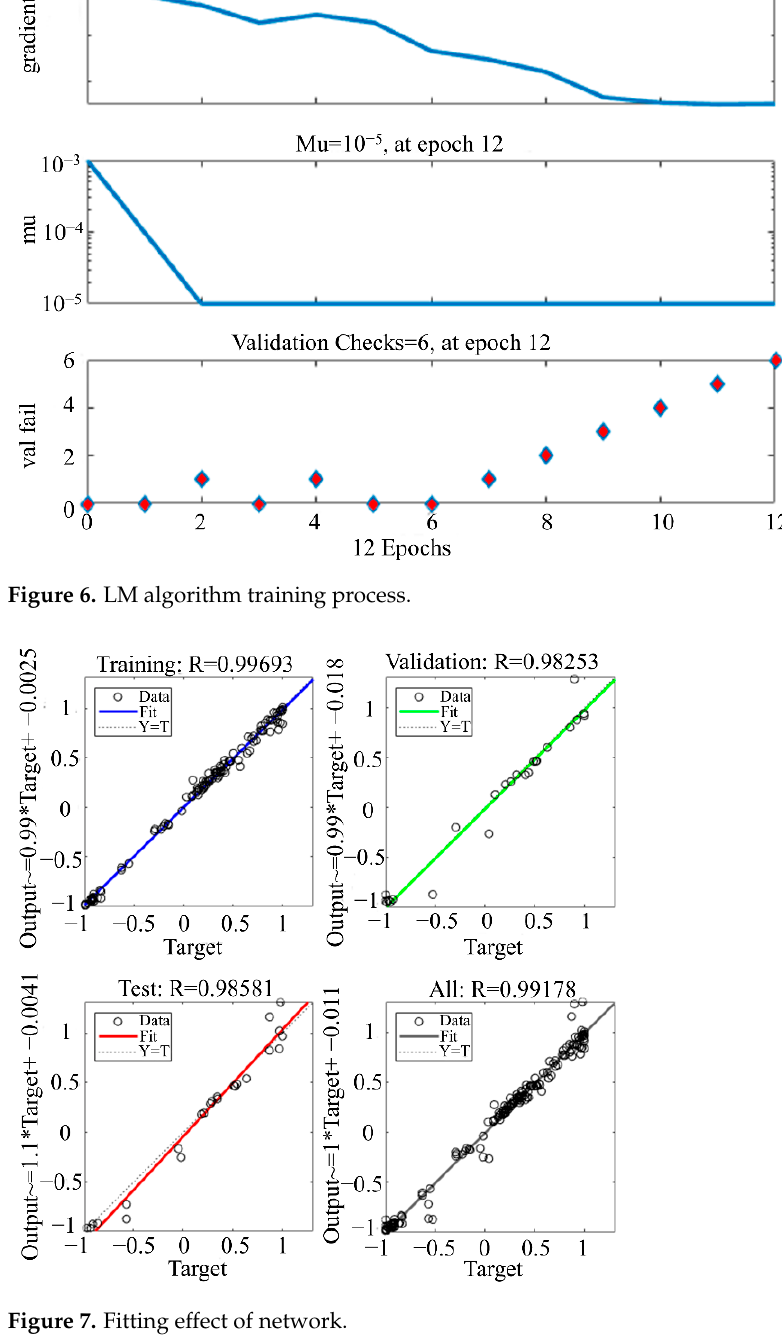
Figure 8. The predicted value of BP ANN on the unit efficiency.